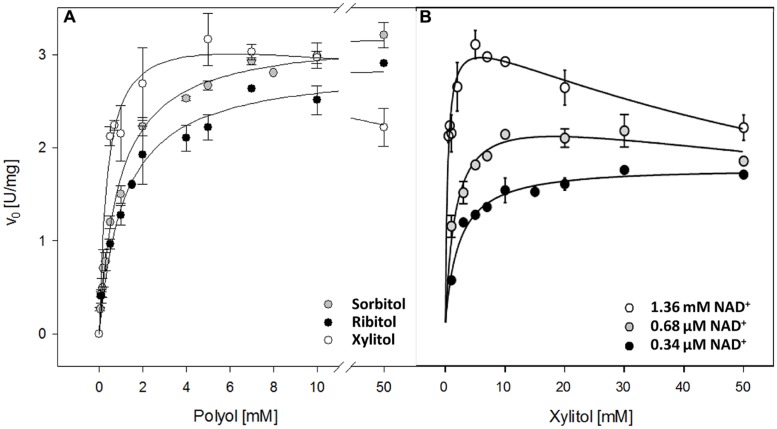
Kinetic properties of recombinant AtSDH. (A) Specific activities were obtained with sorbitol, ribitol, and xylitol as the variable substrate, whilst the co-substrate concentration was held saturating at 1.36 mM NAD+. The continuous lines represent the fit to a hyperbolic function. The values are the means ± SD of at least three independent determinations. (B) Specific activities were obtained with xylitol as the variable substrate, whilst the co-substrate concentration was held at 34 μM, 68 μM, or 1.36 mM NAD+. The continuous lines represent the fit to a substrate inhibition model (not shown). The values are the means ± SE of three independent determinations.